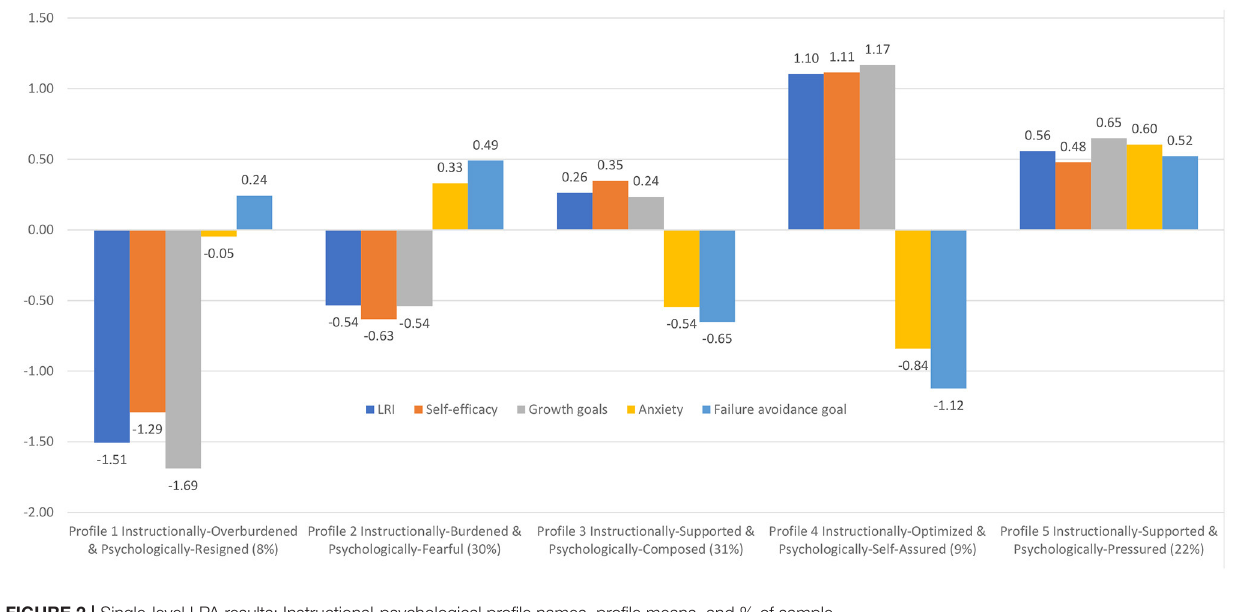
FIGURE 2 | Single-level LPA results: Instructional-psychological profile names, profile means, and % of sample.